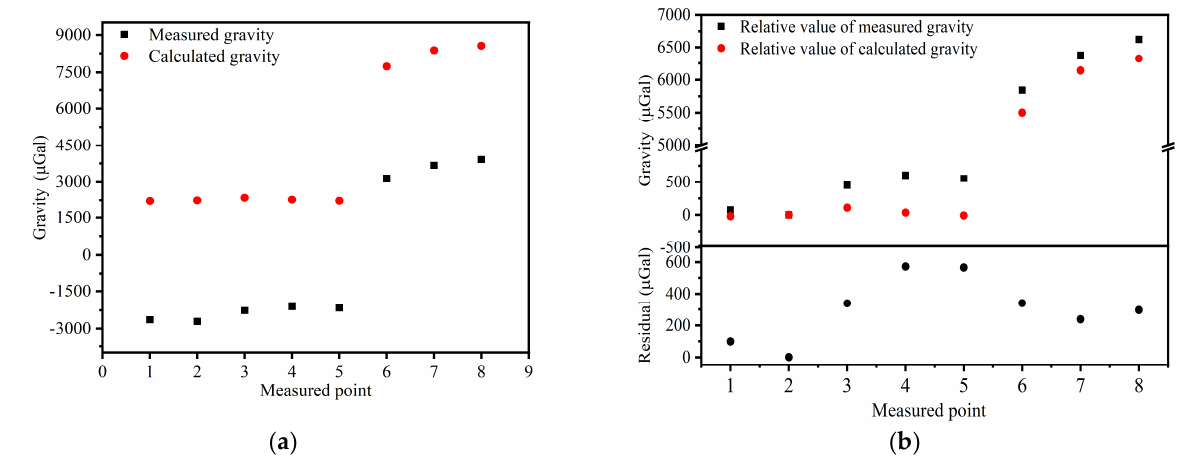
Figure 9. ( a ) Comparison between the gravity measurement results with CAG (the black dots) and the calculation results (the red dots) around the Xianlin reservoir, ( b ) comparison between the gravity measurement results with CAG (the black dots) and the calculation results (the red dots) around the Xianlin reservoir with a reference of the gravity value of point 2.